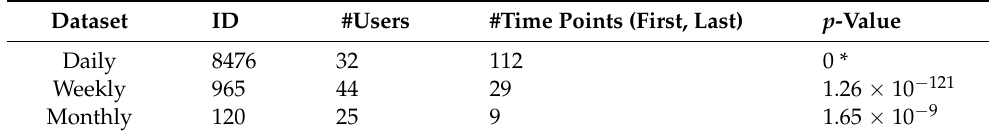
Table 9 selects illustrative time-lagged biclusters for the daily, weekly, and monthly dataset. Bicluster 8476 reveals 32 users that for 112 days show a time-lagged consumption, increasing from moderate to high levels after the first day. Visually depicting this bicluster in Figure 25a), we can see the consumption time series in the bicluster do not necessarily coincide in the same time period. Bicluster 965 unveils 44 users that, for 29 weeks, present a coherently time-lagged consumption pattern. Finally, Bicluster 120 shows 25 users that coherently increased the consumption from medium to high after one month for 9 months (dispersed for the entire year due to time-lags). Table 9. Time lagged biclusters picked for each of the datasets.